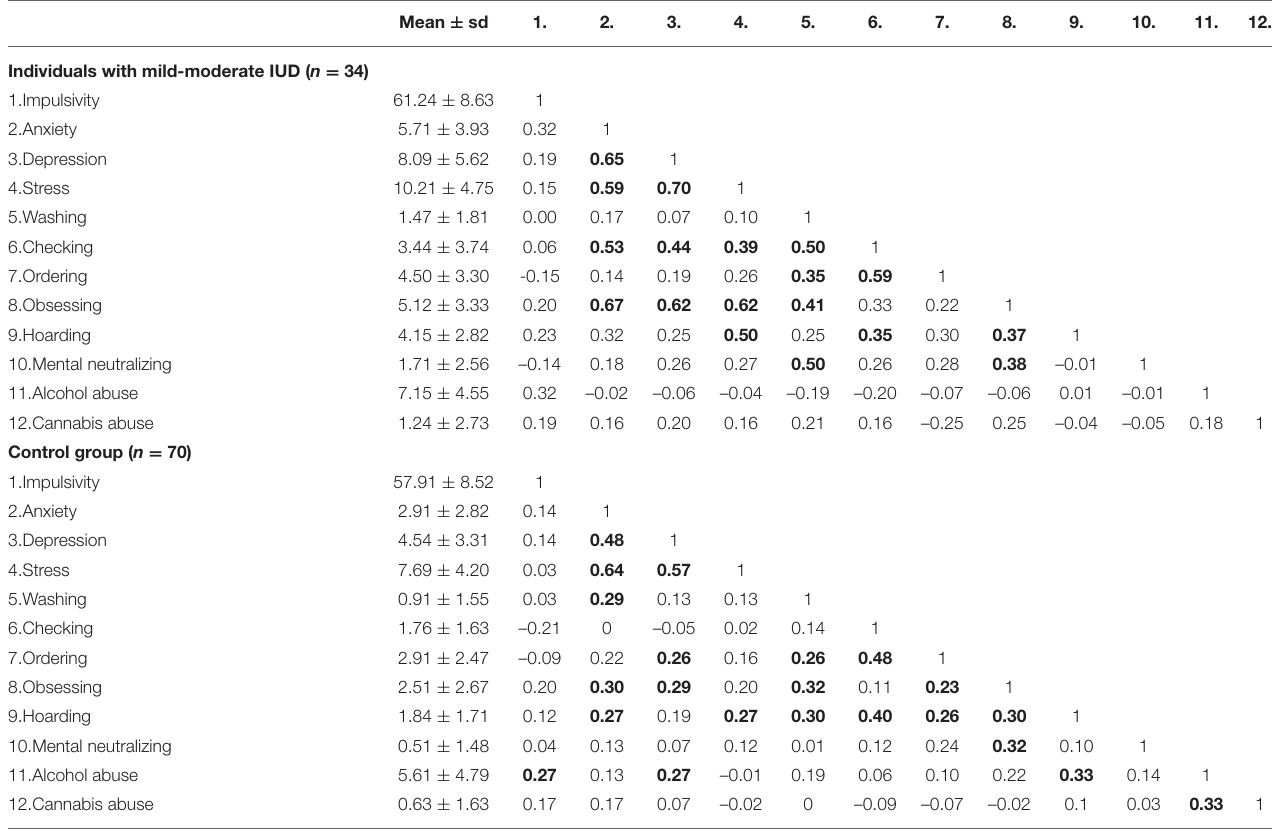
TABLE 1 | Descriptive statistics and Pearson’s correlations in individuals with mild to moderate IUD and